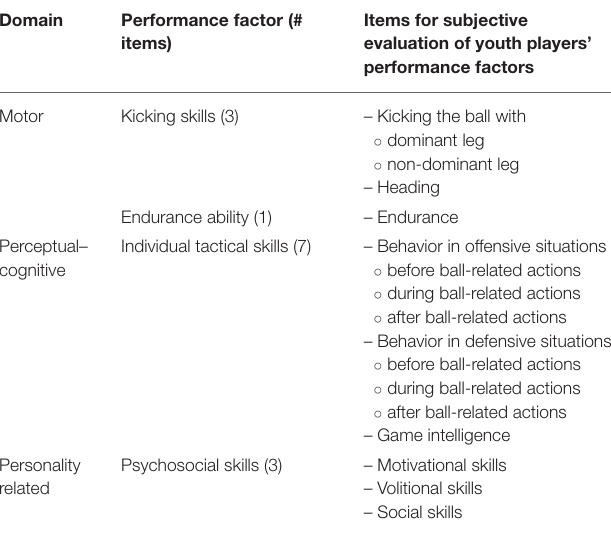
TABLE 1 | Subjectively assessed youth players’ performance factors serving as potential predictors for future success.